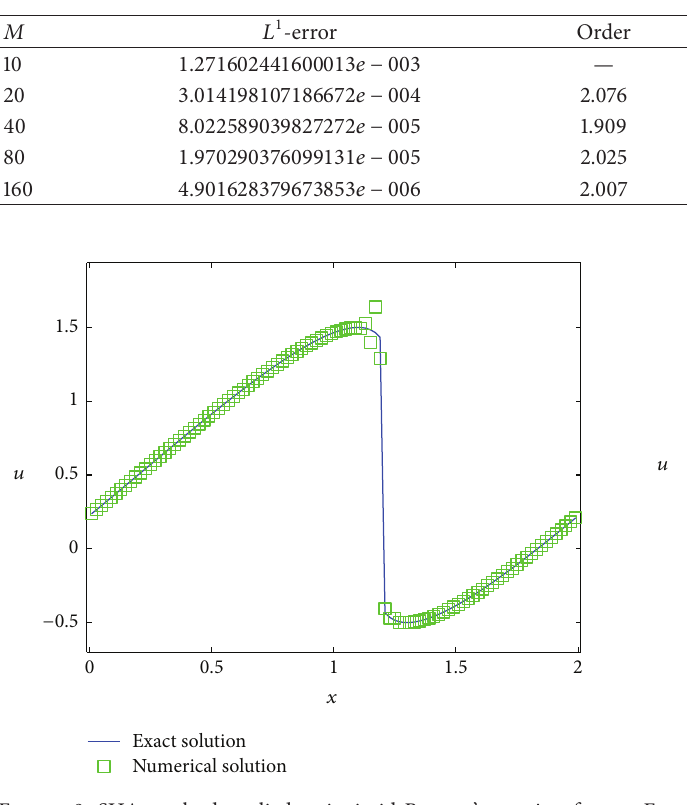
Figure 9: SHA method applied to inviscid Burgers’ equation for continuous initial value; numerical (symbols) and exact (line) solutions are compared at 𝑡 = 0.4 units.